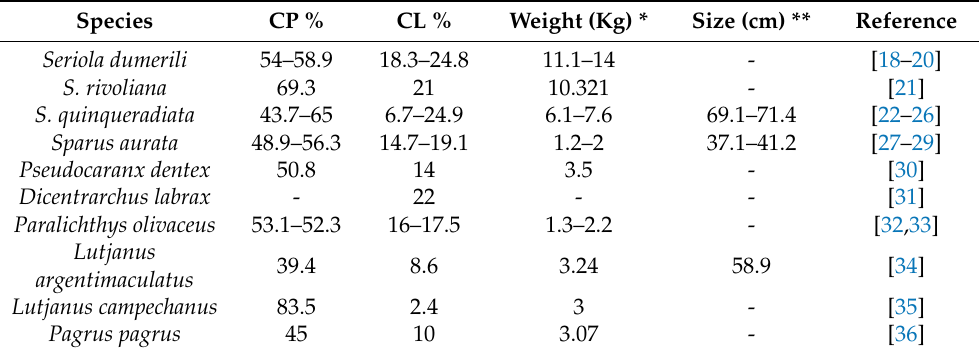
* Average weights; ** average sizes; - data not